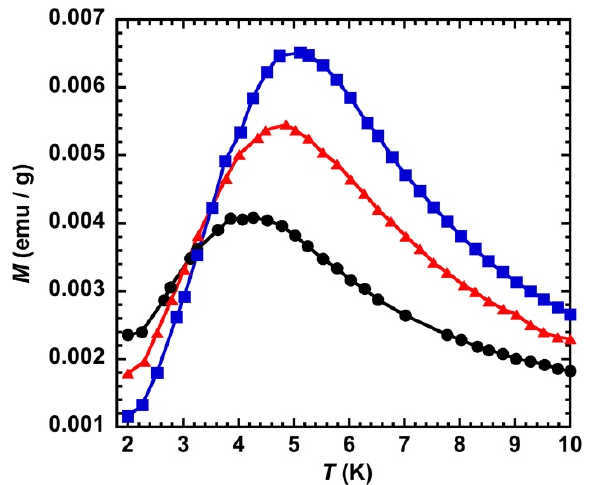
Figure 8. ZFCM after irradiation with laser power values of 20 ( • ), 65 ( (cid:78) ), and 150 ( (cid:4) ) mW/cm 2 , for CsCoFe_PVP.